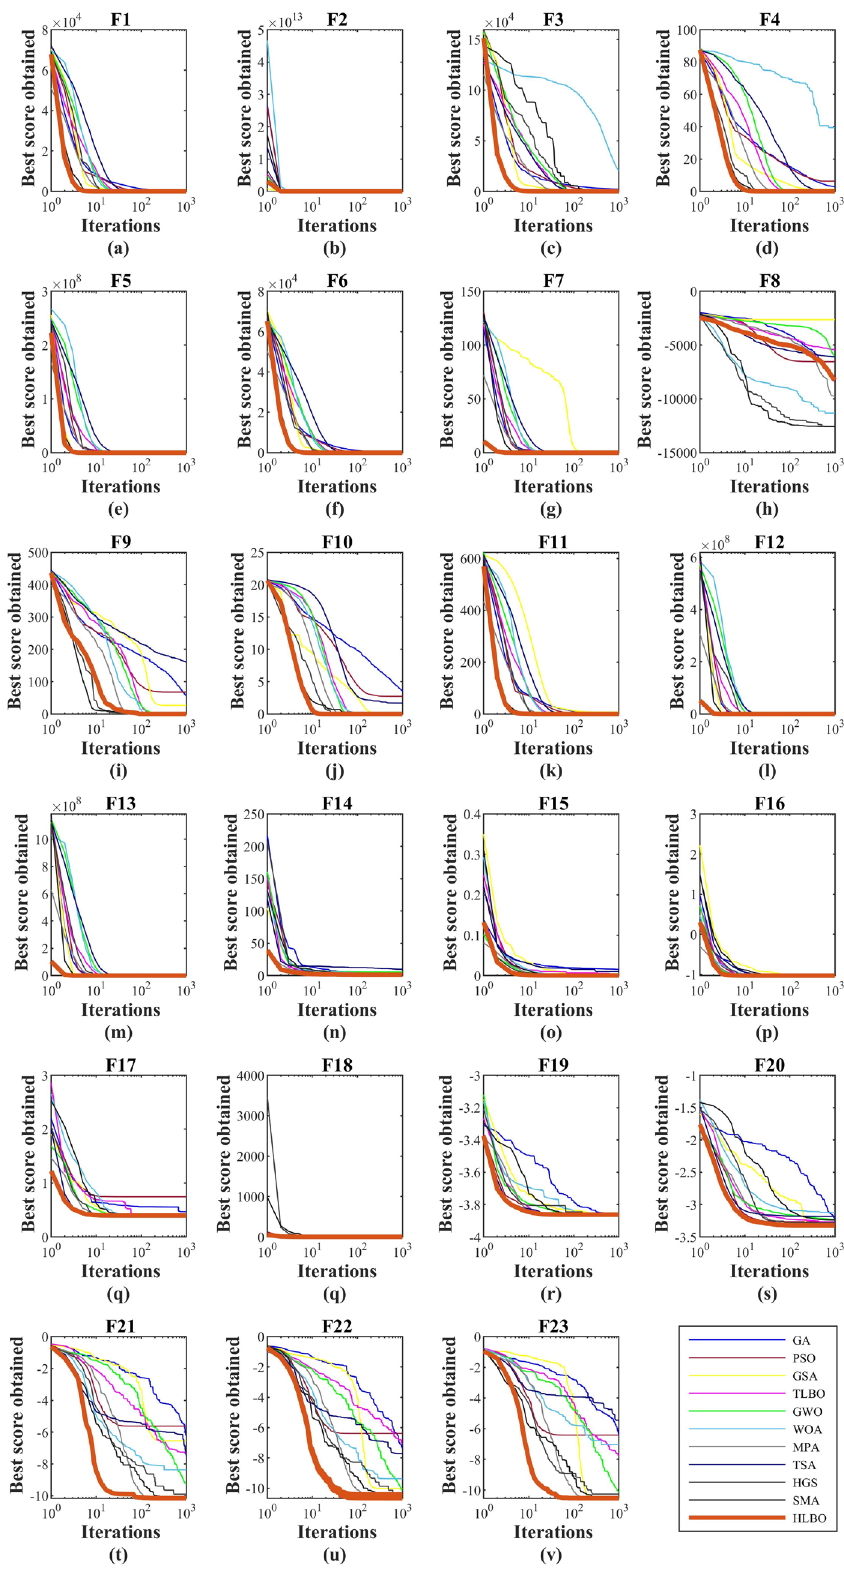
Figure 2. Convergence curves of the HLBO and competitor algorithms in optimizing objective functions F 1 to F 23